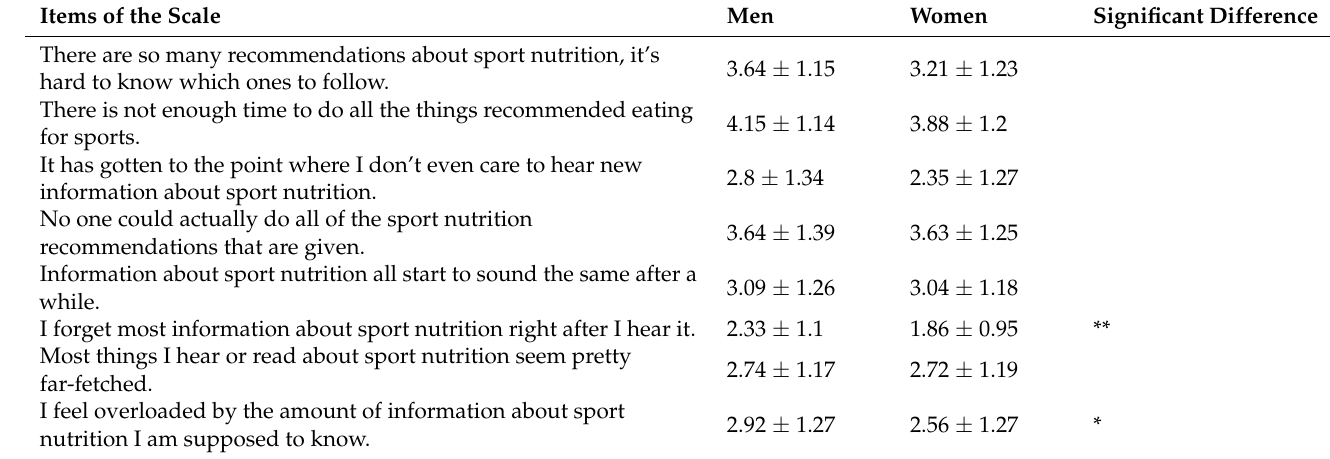
Table 4. Average and standard deviation of responses by gender. Significance levels are marked with * at p < 0.05 and ** at p < 0.01.